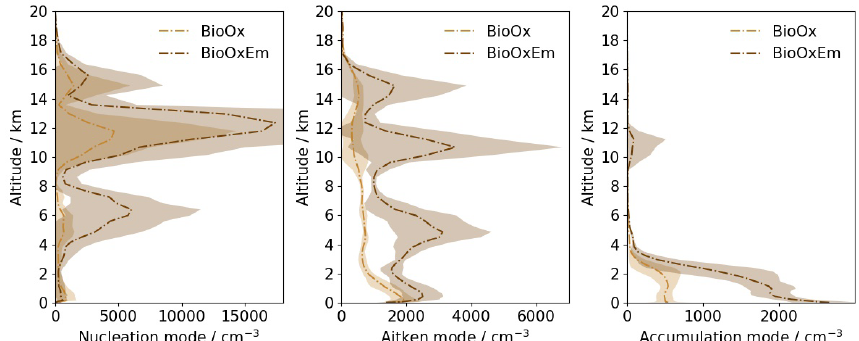
Figure A2. The domain-averaged profiles of the nucleation, Aitken and accumulation mode aerosol in the simulations BioOx and BioOxEm from the global model in the upwind (east) of the regional